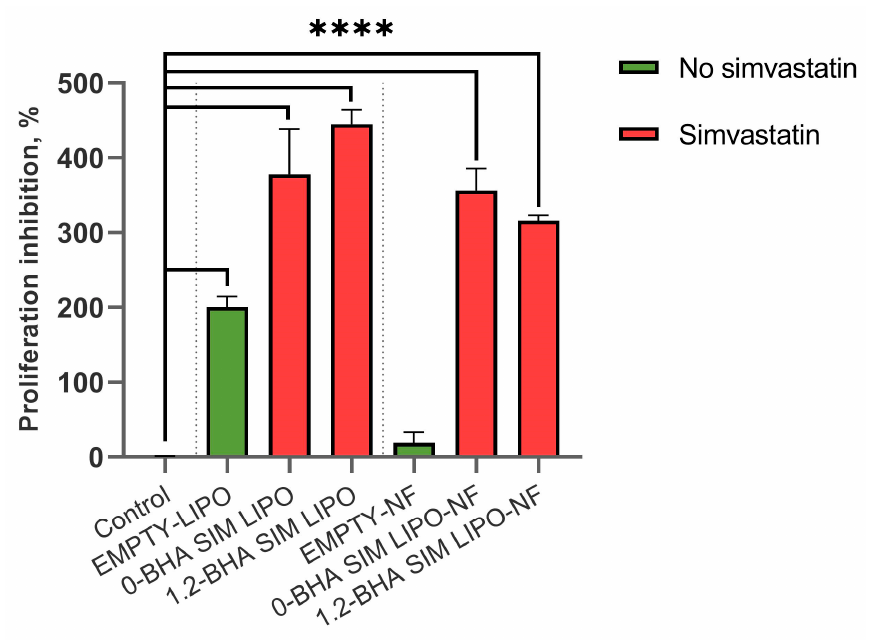
Figure 9. The inhibitory effects of the formulations on PHA-L-induced T-lymphocyte proliferation. Data are presented as means ± SD ( n = 3). **** p < 0.0001.